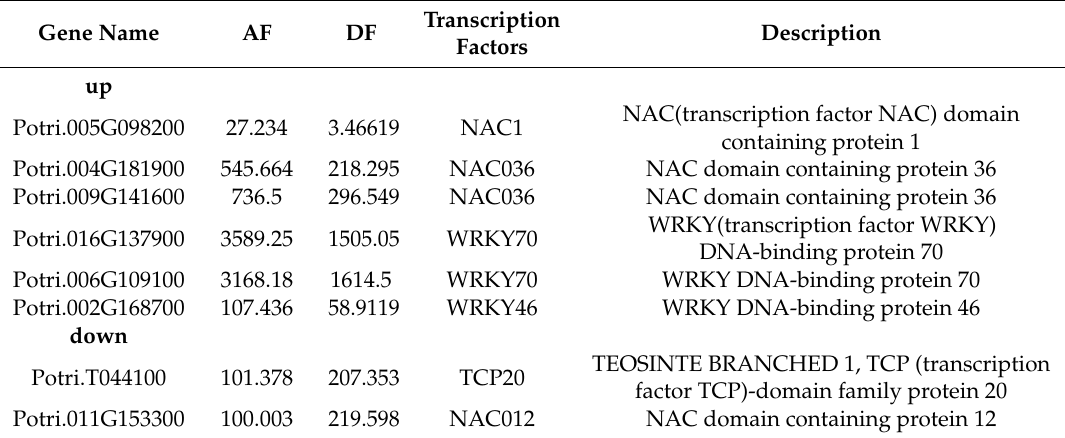
NAC domain containing protein 36